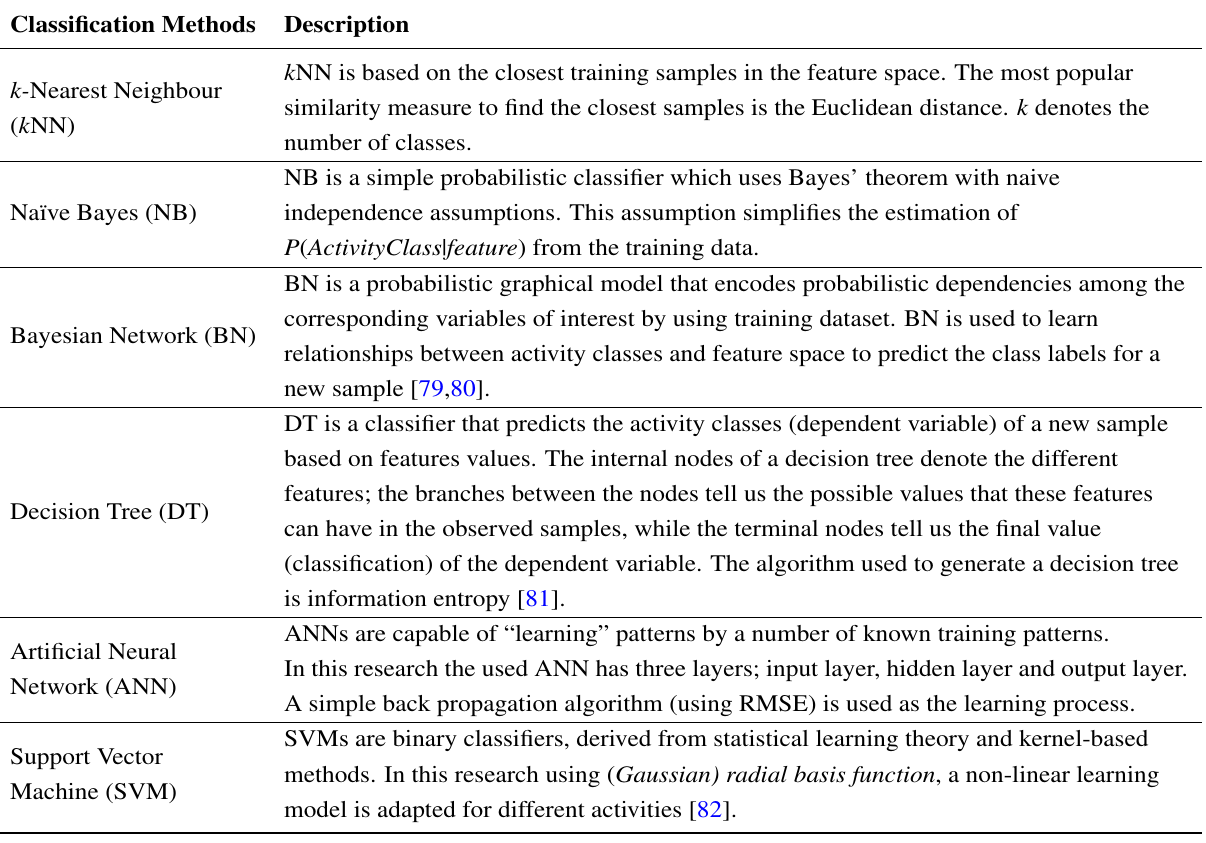
Table 5. Categorization of the classification